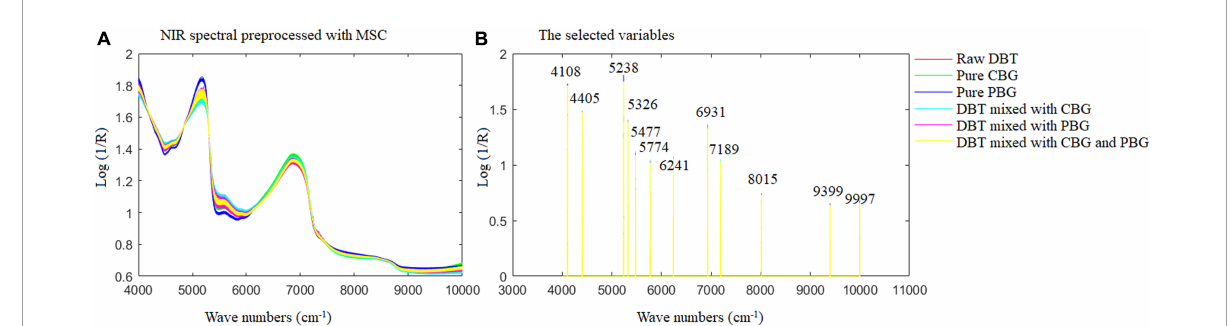
FIGURE6 The multivariate scattering correction spectra of the samples prepared and used (A) and the selected wavenumbers (B) for Fisher LDA and ELM modeling. DBT, Duck blood tofu; CBG, cow blood-based gel; PBG, pig blood gel.